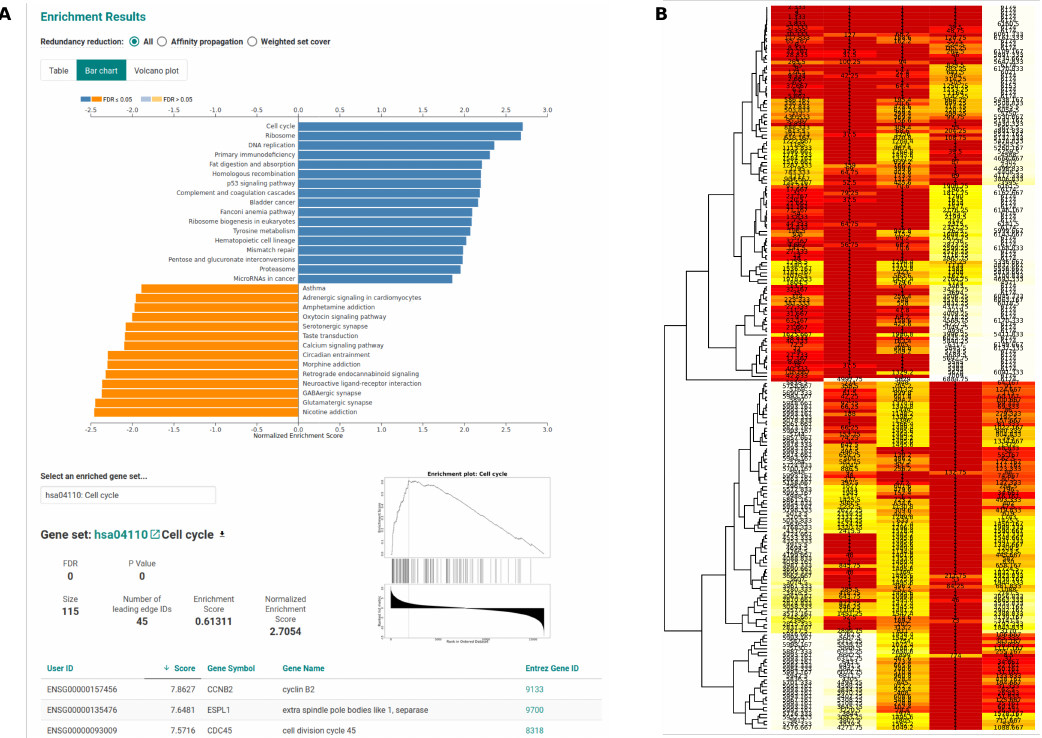
Figure 4. Downstream pathway analysis. ( A ) shows a cutout of the gene set enrichment analysis (GSEA) HTML results generated by WebGestalt , ( B ) shows the consensus scoring of the GSEA result from the piano R